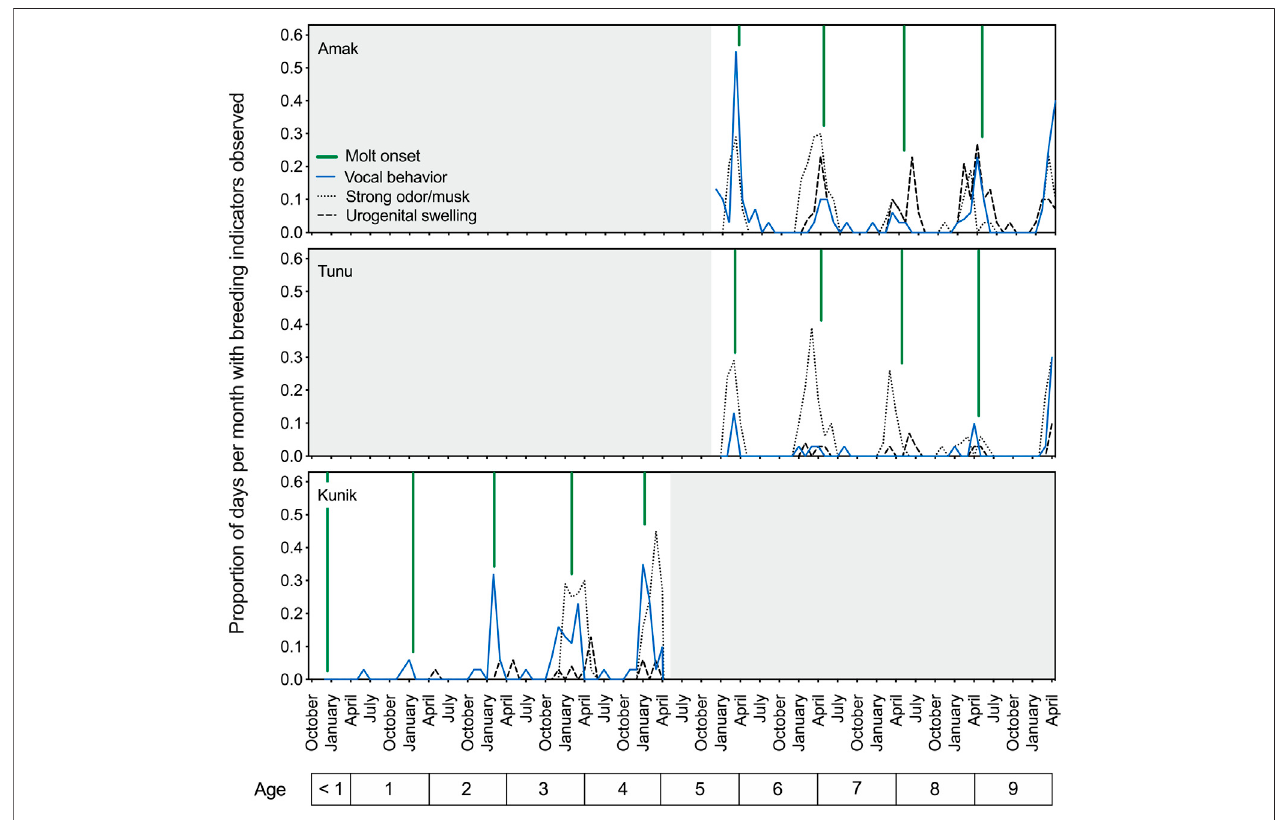
FIGURE 2 | Temporal patterns in breeding indicators observed in three male spotted seals over an interval of 5 years (December 2015 to April 2020). The proportion ofdays permonth when vocal behavior(inairor water),strong musky odor,orurogenital swellingwerenotedbyhusbandry staffareplotted asseparate lines over time,andarereferencedtotheageofeachseal(noted below).Acrossindividuals,there iscleartemporaloverlap betweenthese threecues,withtheirannualpeaks also corresponding wellwiththepresumed breedingseasonforthisspeciesanddecliningaroundmoltonset(denotedbythegreenverticallines)eachyear. These